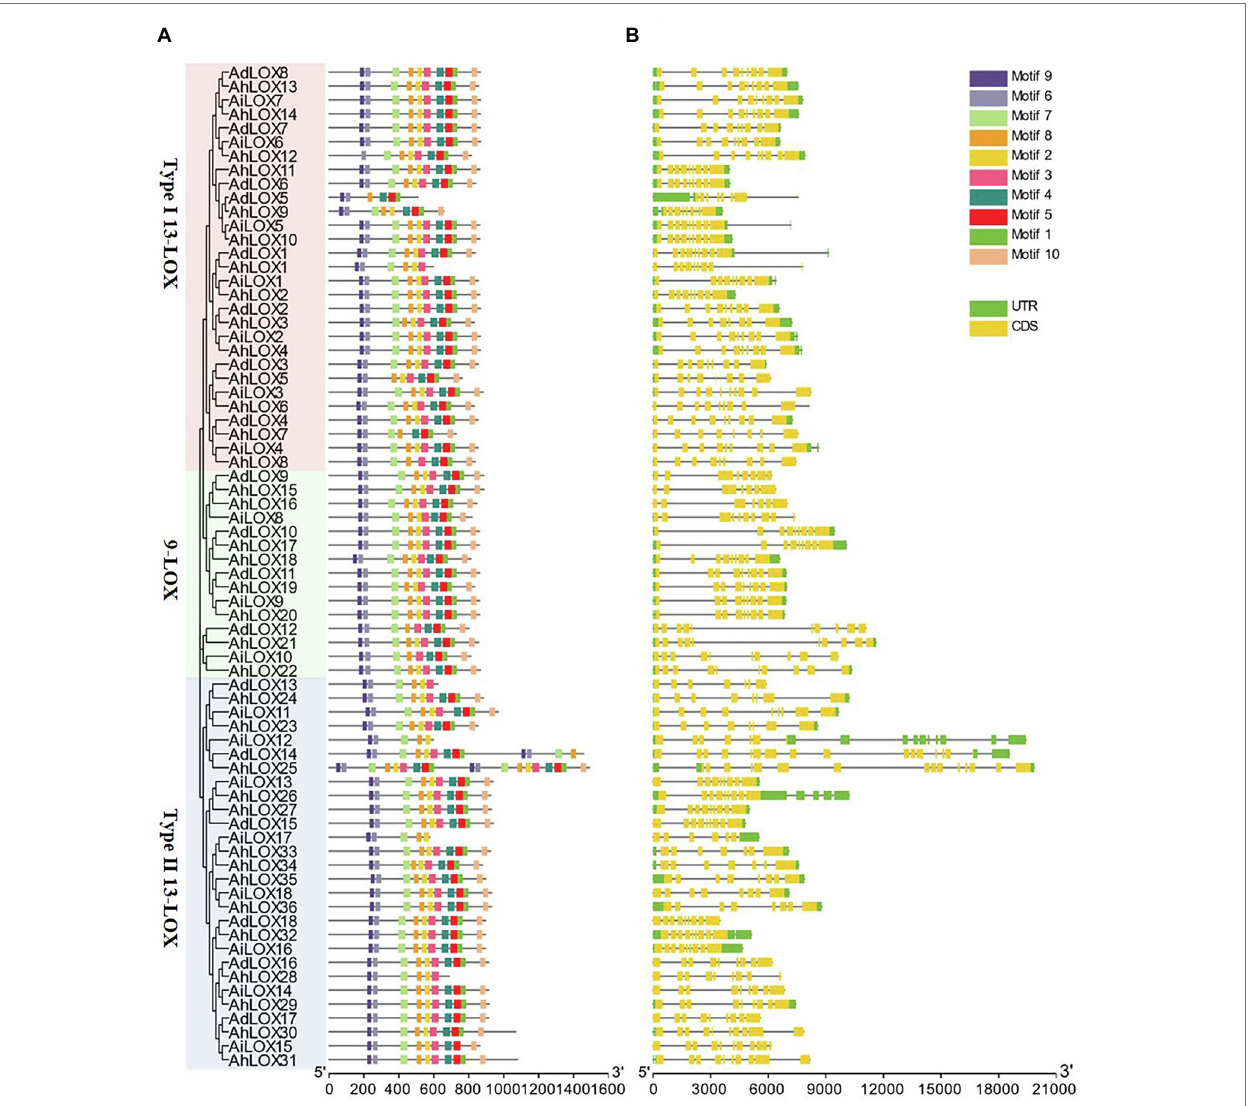
FIGURE 3 | Phylogenetic relationship, gene structure and conserved-motif analysis of the LOX genes in peanut. The maximum-likelihood phylogenetic tree was constructed using MEGA X with 1,000 replicates. (A) Conserved motifs of LOX proteins. Ten conserved motifs are shown in different-colored boxes, and detailed information on the motifs is provided in Supplementary Table S3 . (B) Exon-intron structures of LOX genes. The yellow boxes represent exons, and the gray lines represent